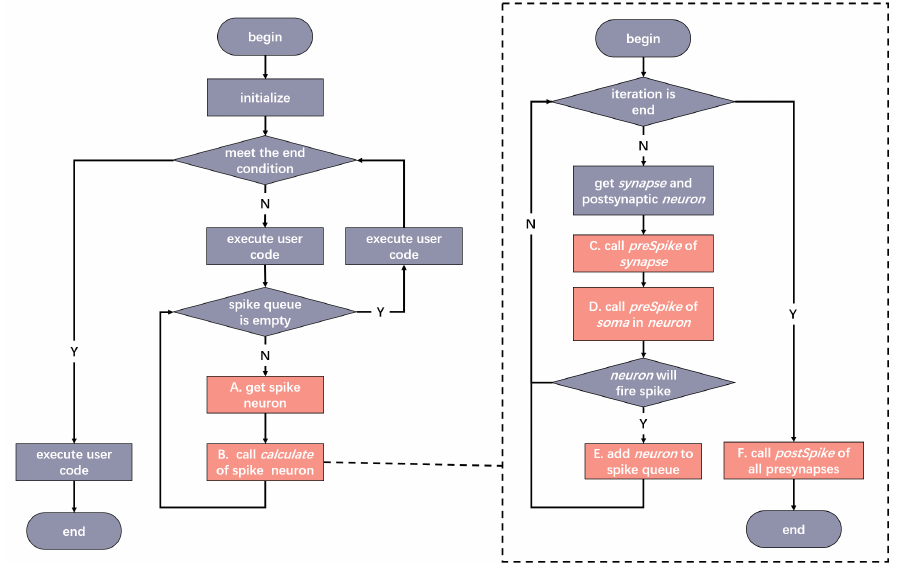
Figure 6. EDHA workflow. The left is the overall workflow, and the right is the details after step B is expanded. The steps in red in the flowchart correspond one-to-one with the steps marked with letters in Figure 7.